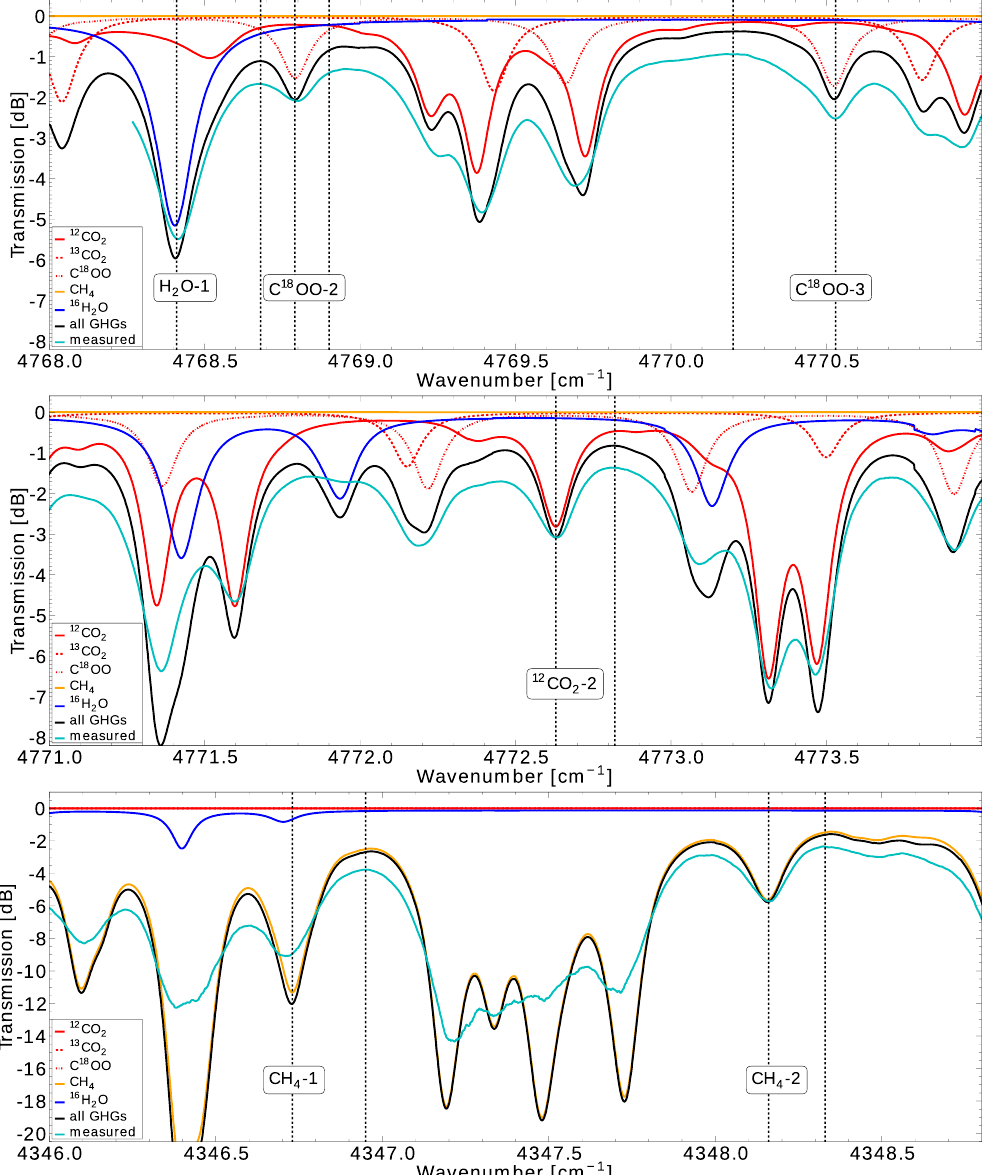
Figure 4. Examples of simulated transmission spectra of targeted GHG isotopes (see in-panel legends; for H 2 O and CH 4 the main isotopes are utilized), of corresponding total transmission spectra from all GHGs (black curves), and of associated measured spectra (cyan curves). The respective absorption line center frequencies and nearby reference frequencies, according to Table 4, are marked by dash-dotted vertical lines, and the corresponding target GHGs are noted below the respective absorption line peaks. Three example wave number ranges are illustrated: one containing lines for H 2 O-1, C 18 OO-2, and C 18 OO-3 (top panel); one for 12 CO 2 -2 (middle panel); and the two lines chosen for CH 4 (bottom panel). The transmission alignment of the measured and simulated spectra is done in these panels for the C 18 OO-2, 12 CO 2 -2 and CH 4 -2 absorption peaks,